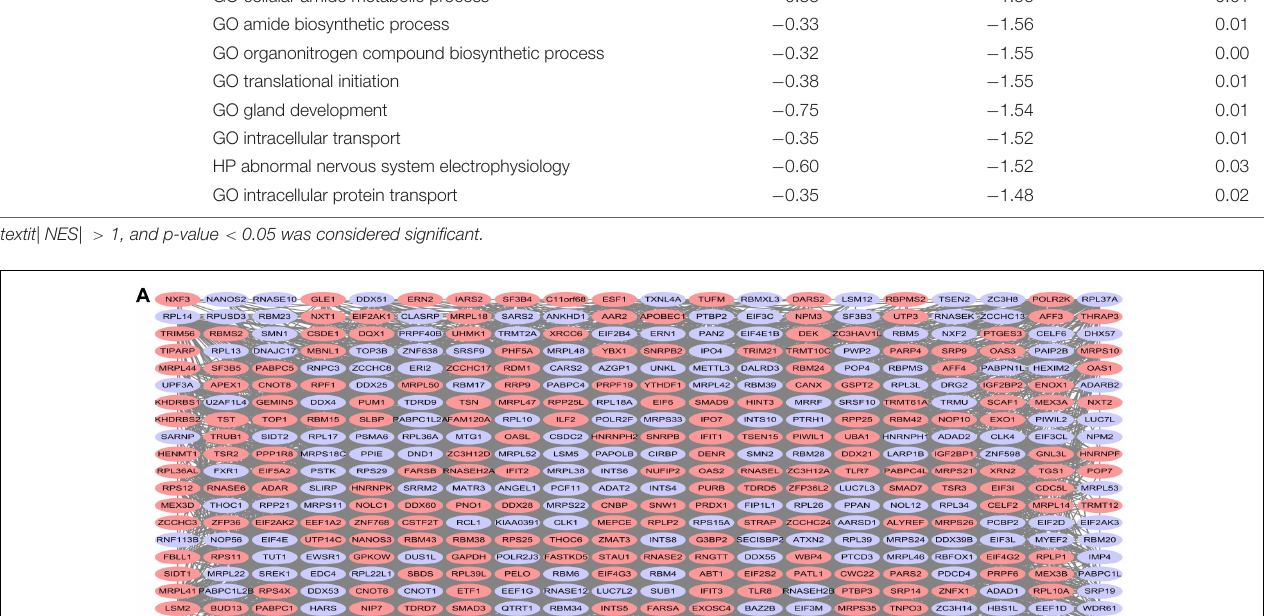
verified favorable accuracy (AUC value was 0.728 and 0.727, respectively) ( Figures 6C,D ). Risk curves further confirmed that the higher the risk score, the lower the survival